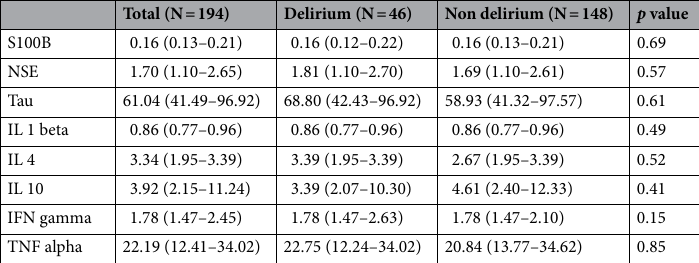
Table 2. Results of biomarkers at admission in delirium and non-delirium patients.